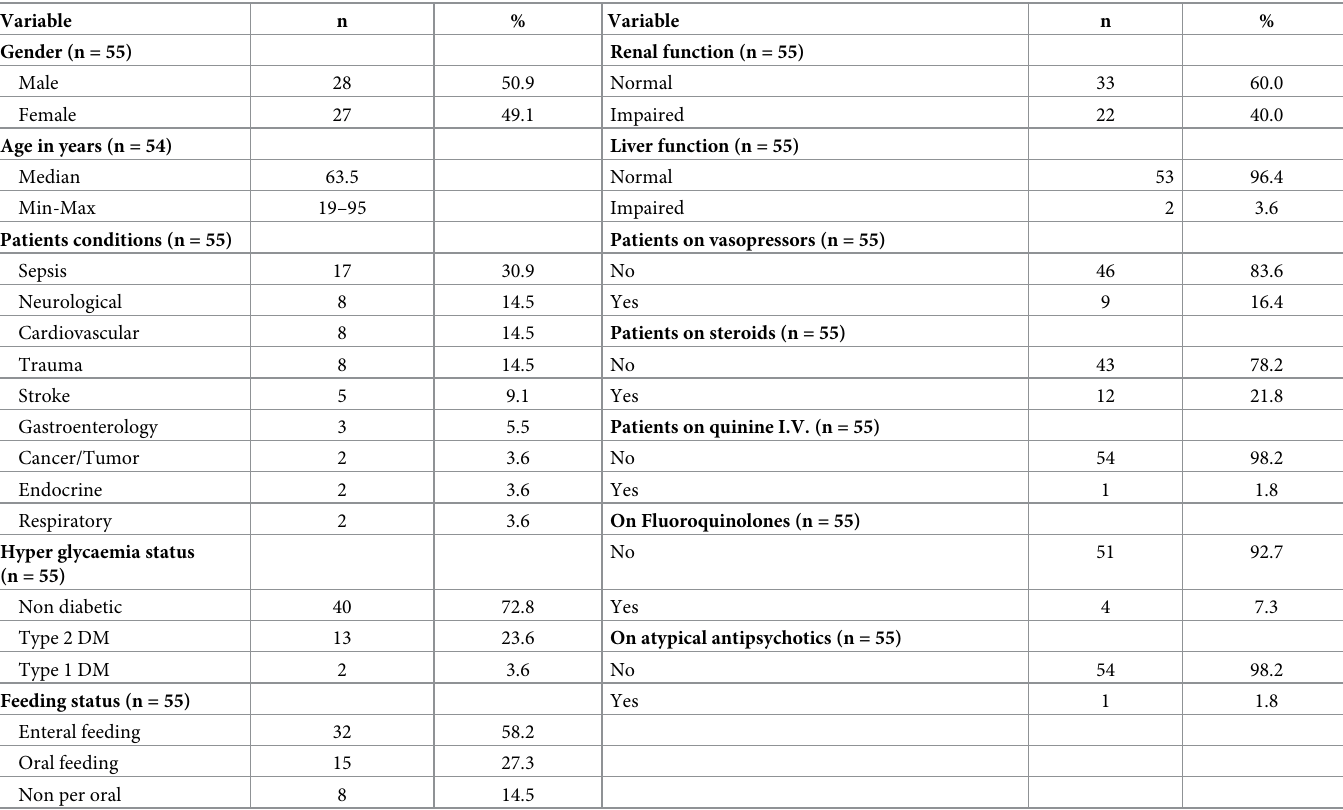
Table 2. Characteristics of the patients hospitalized in the ICUs of the Military Hospital (n = 55).